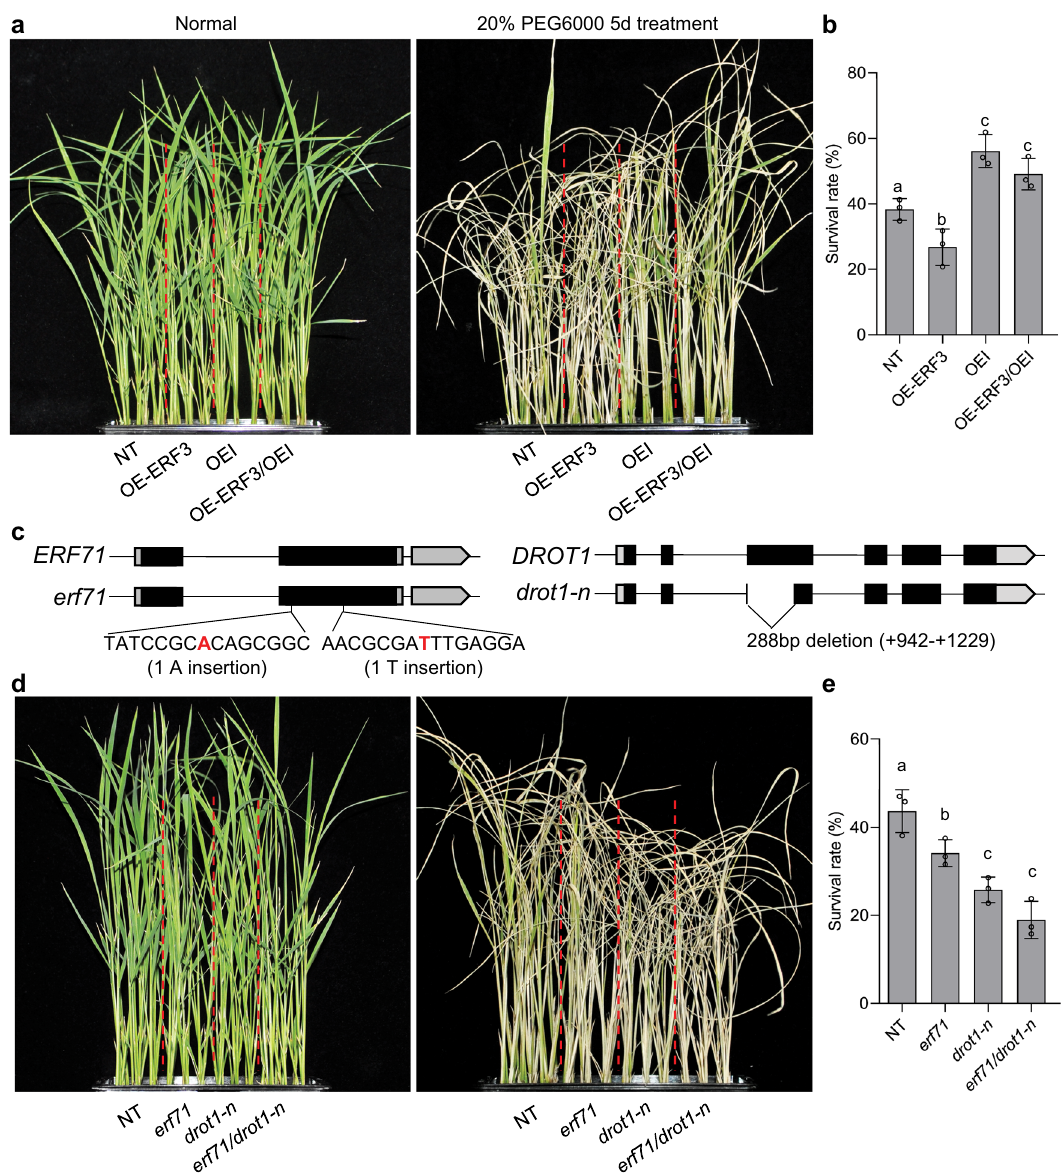
Fig. 6 DROT1 genetically interacts with ERF3 and ERF71 to regulate drought resistance. a , b Resistance of NT, OE-ERF3, OEI, and OE-ERF3/OEI plants to drought stress simulated by 20% PEG6000. Seedlings grown for 2 weeks under normal conditions ( a , left) were treated by 20% PEG for 5 days, followed by re-watering for 7 days ( a , right). Statistical analysis of seedling survival rates after re-watering ( b ). Data are means± s.d. ( n = 3 biological replicates). c Diagram of ERF71 and DROT1 knockout lines. d , e Resistance of NT, erf71 , drot1-n , and erf71/drot1-n double mutant plants to drought stress simulated by 20% PEG6000. Data are means ± s.d. ( n = 3 biological replicates). Different letters indicate statistically signi fi cant differences at P = 0.05 by one-way ANOVA with Duncan test. Source data are provided as a Source Data fi